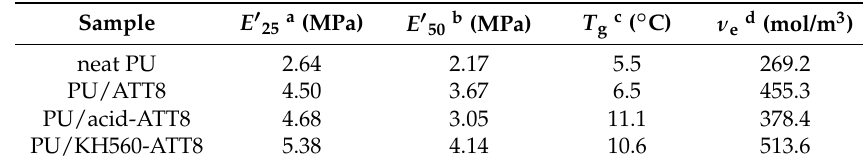
Table 1. Dynamic mechanical properties of neat PU and PU nanocomposites containing 8 wt % ATT, acid-ATT and